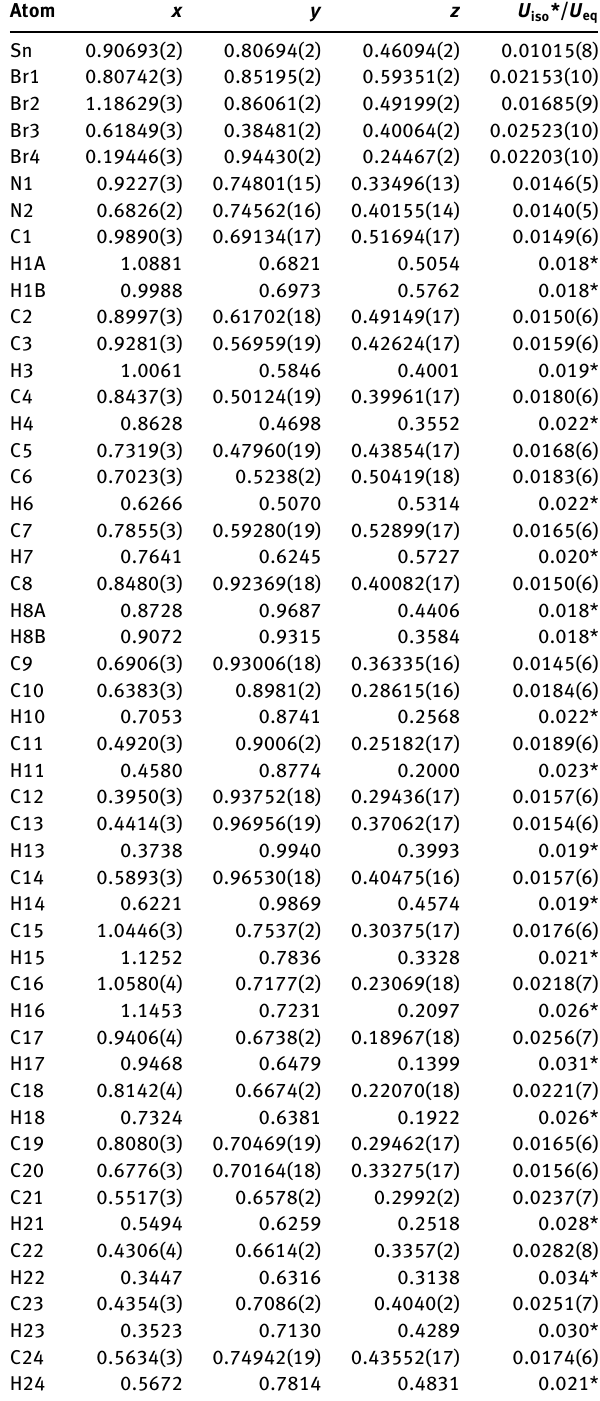
Table 2: Fractional atomic coordinates and isotropic or equivalent isotropic displacement parameters (Å 2